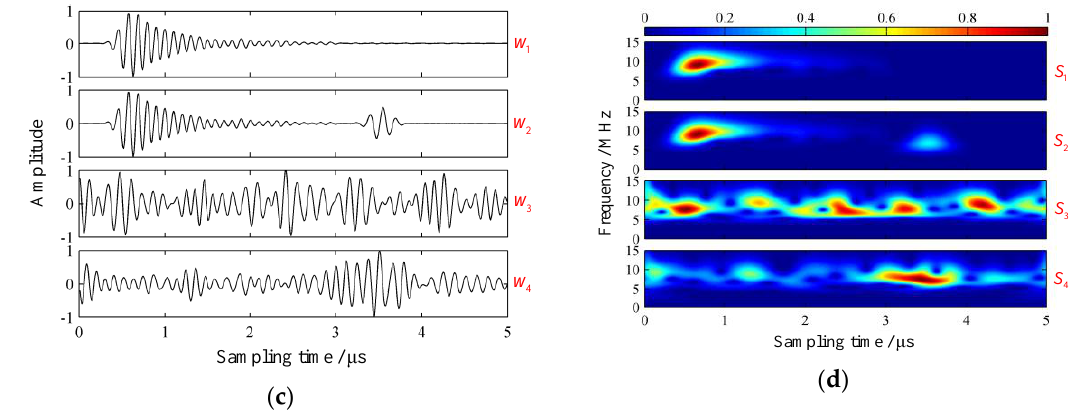
Figure 4. Simulated results of four typical cases. ( a ) Frequency response functions; ( b ) frequency spectrums; ( c ) waveforms; and ( d ) generalized Stockwell transform spectrums.